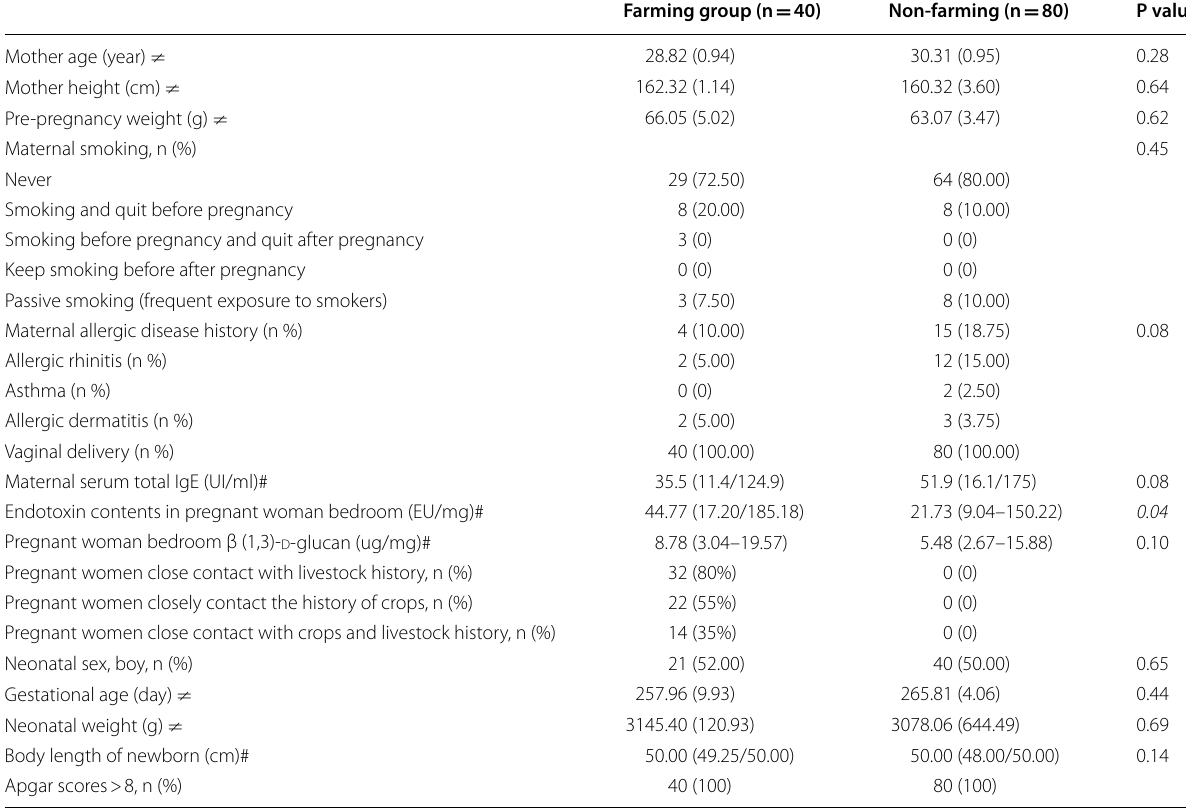
The values are represented as mean SEM (marked as ≠ ) or median (25%/75% IQR) (marked as #). T-test or Mann–Whitney rank test or X2 test were used to compare ± the two groups. Italic value indicates statistical significance (P < 0.05)